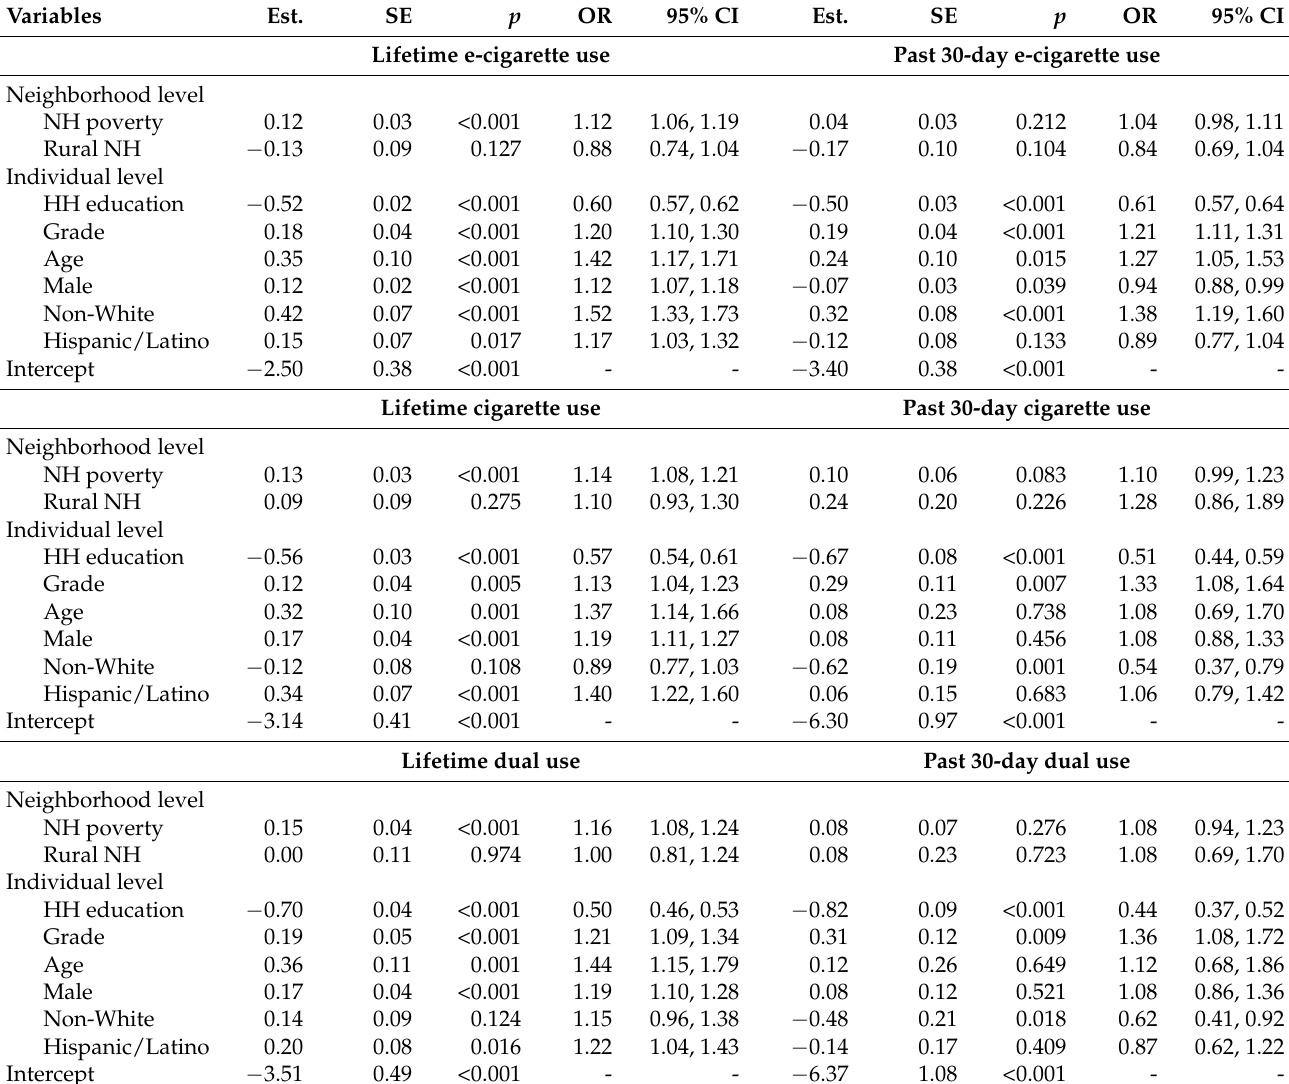
Table 3. Results of logistic regression models for neighborhood- and individual-level lifetime and past 30-day e-cigarette use, cigarette use, and dual